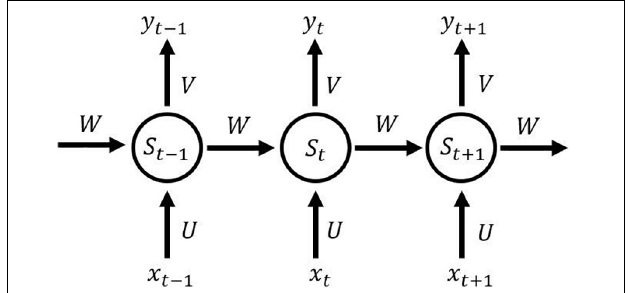
FIGURE 6 | Illustration of recurrent neural network. FIGURE 7 | Illustration of